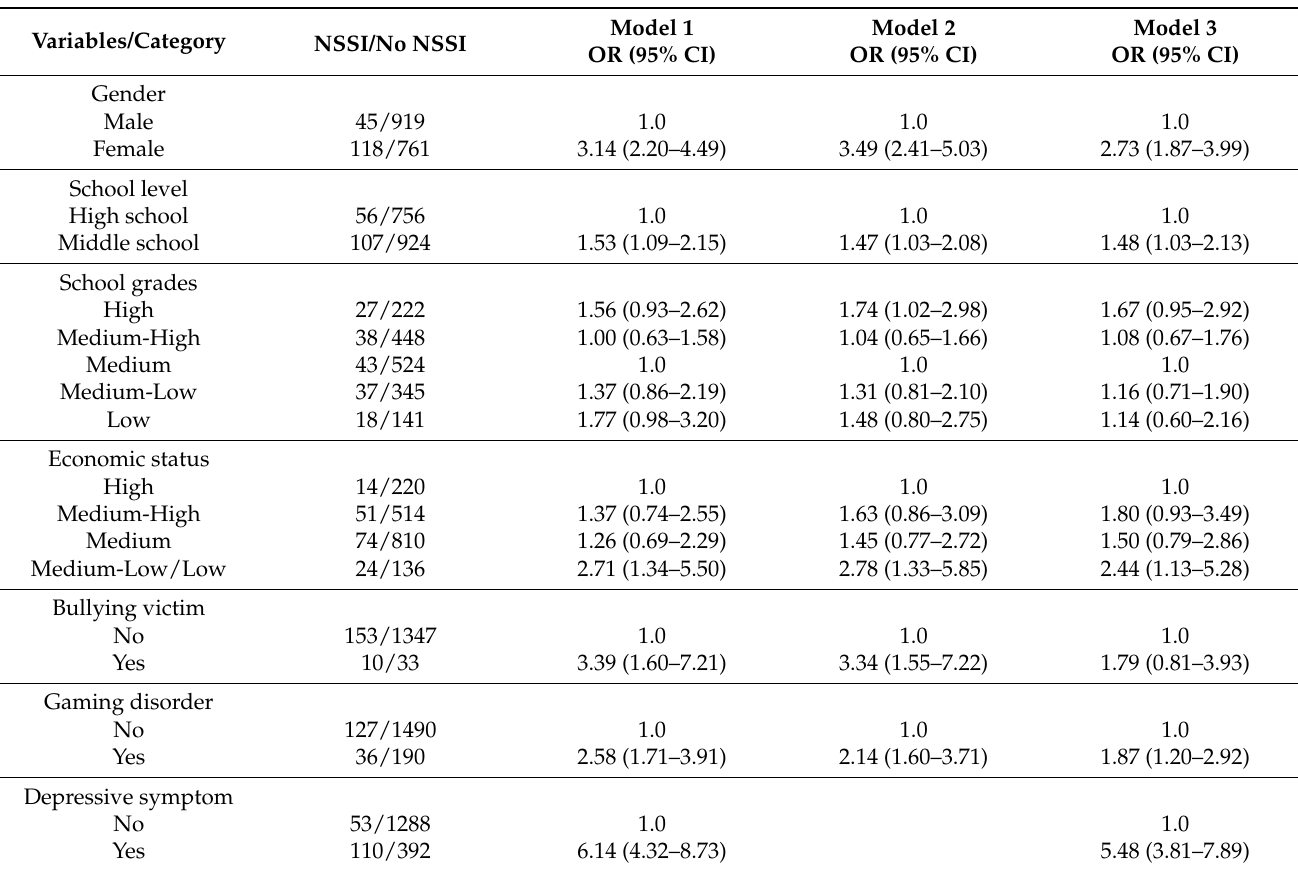
Table 3. Related factors with non-suicidal self-injury among adolescents in South